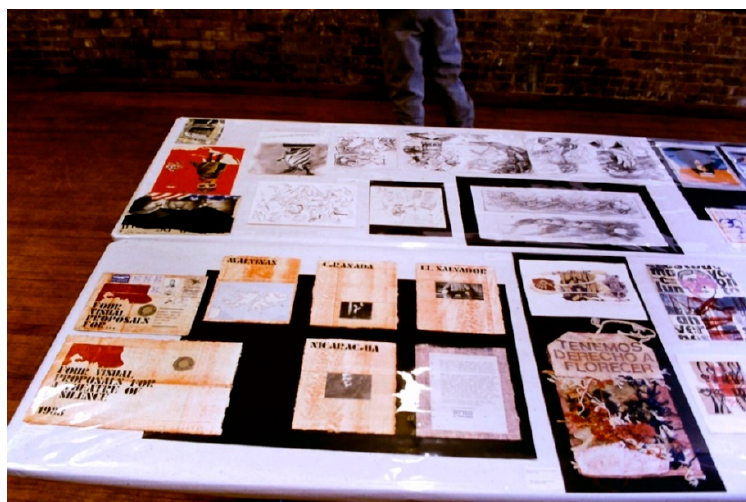
Figure 8. Installation shot, Solidarity Art by Mail , Judson Memorial Church benefit exhibition for Artists Call Against U.S. Intervention in Central America, 1984. Artists Call Against US Intervention in Central America, miscellaneous uncatalogued material, MoMA Library, used by permission.